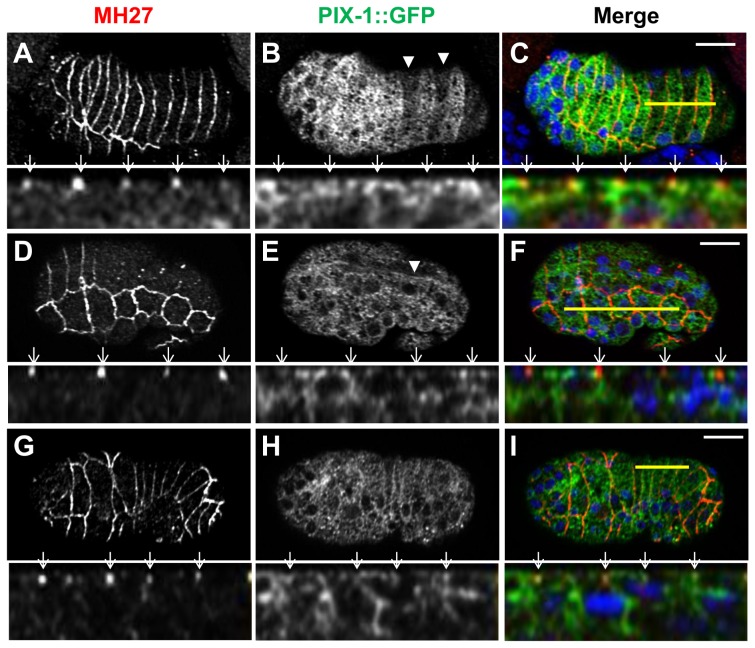
PIX-1 is homogeneously distributed in the cytoplasm and at the cell periphery of hypodermal cells.A–I) Immunostaining of pix-1(gk416); sajEx1[pix-1p::pix-1::gfp] expressing embryos with MH27 antibodies (A, D, G and red in merge panel C, F, I) and anti-GFP antibodies (B, E, H and green in merge panel C, F, I). Lower panel of each view correspond to orthogonal views of embryos Z-sectioning. Position of Z-sectioning is indicated in upper panel by a yellow line in dorsal (A–C) and lateral (D–F) and ventral (G–I) hypodermis. In orthogonal views, arrows point to adherens junctions which partially colocalize with PIX-1::GFP immunostaining. Arrowheads show the decrease in PIX::GFP expression every other cell in the dorsal-posterior hypodermis (at comma stage) in picture B (upper panel); Arrow-head indicates dorsal trans-epithelial attachment structures (TEA) in picture E (upper panel). Scale bars: 10 µm.